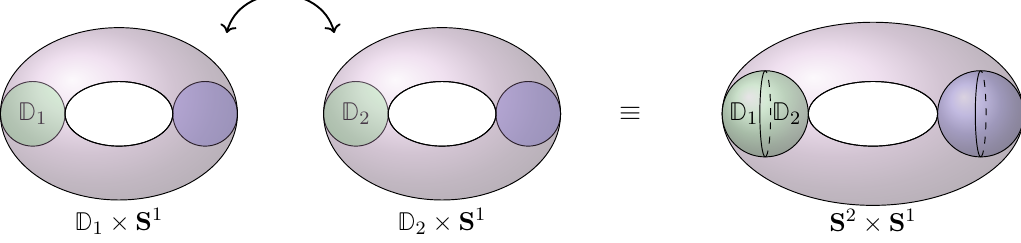
Figure 24 . Gluing two solid tori D 1 (cid:2) S 1 and D 2 (cid:2) S 1 such that the a -cycles on the boundary tori are identi(cid:12)ed. The resulting 3-manifold is S 2 (cid:2) S 1